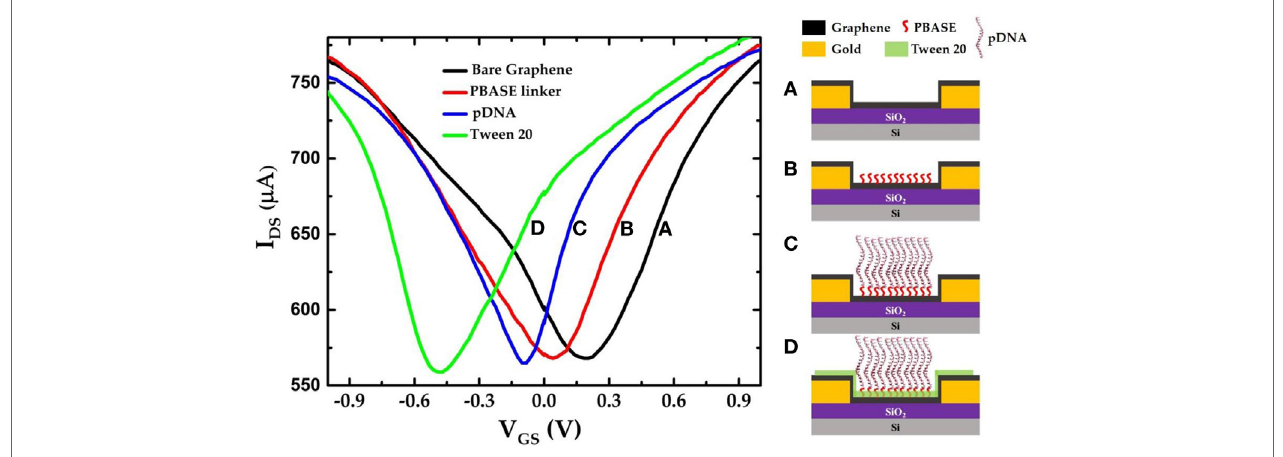
FigUre 3 | I DS – V GS characteristics of the graphene field-effect transistor device (a) before any surface modification (unmodified graphene); (b) after PBASE functionalization; (c) after attaching single-strand probe DNAs (pDNAs) to the PBASE linker; and (d) after treating the graphene surface with 0.1% Tween